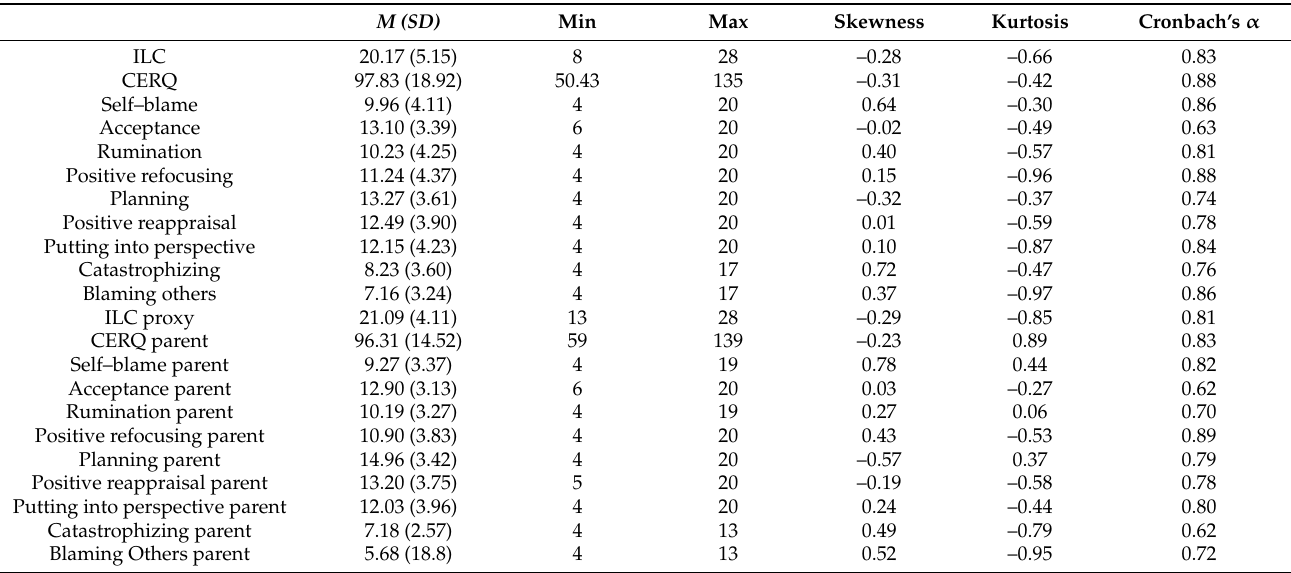
Table 2. Descriptive statistics and reliabilities of study